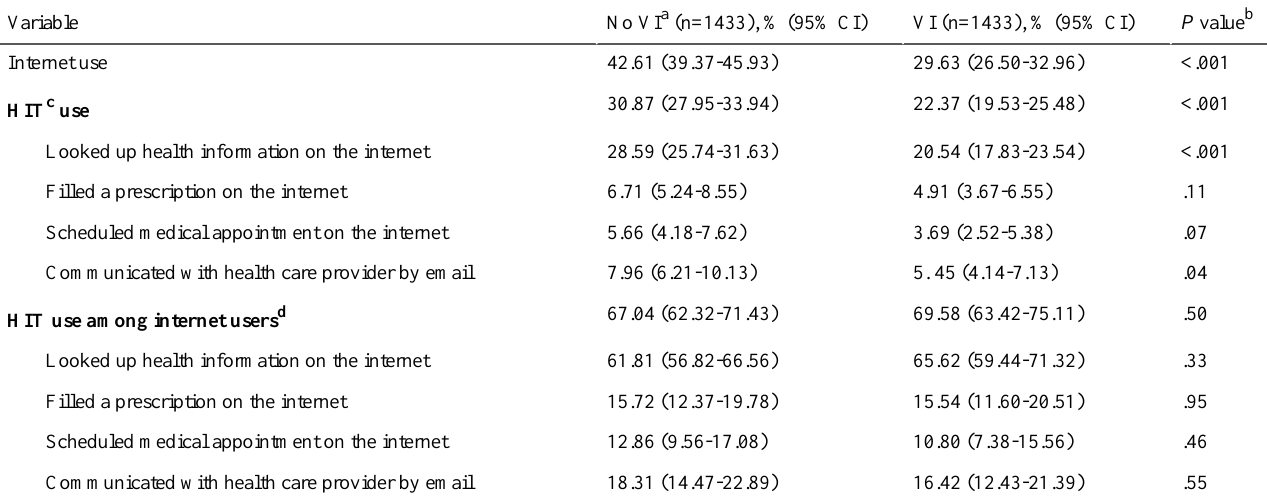
Table 2. Internet and health information technology use in the past 12 months among the matched